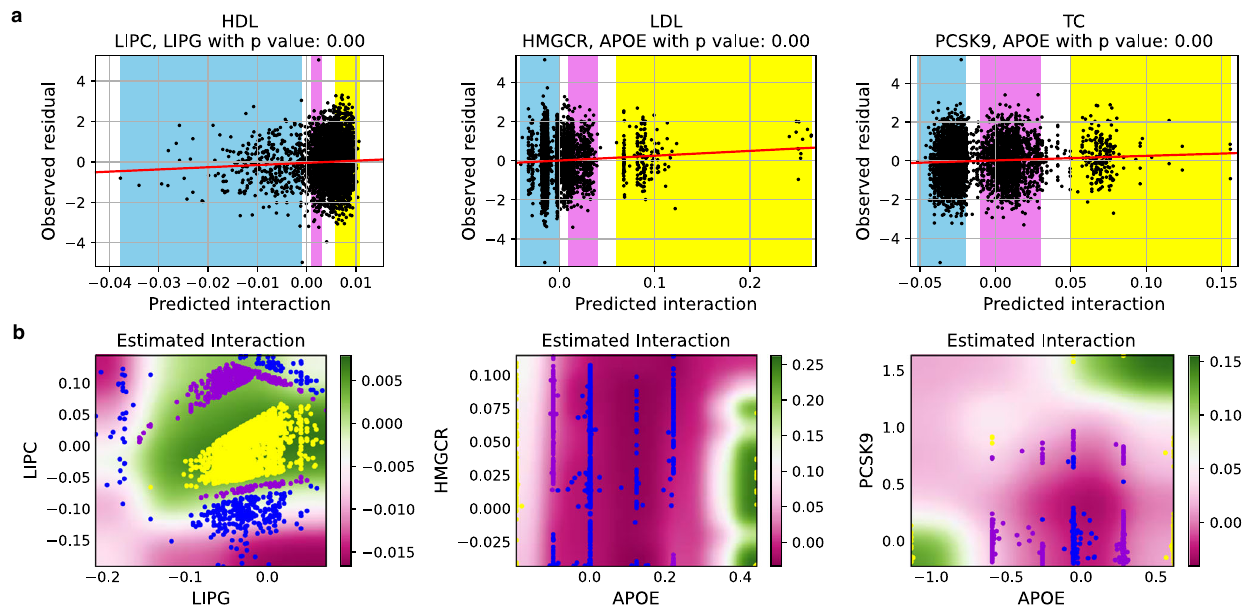
Fig. 7 Visualization of one interaction replicated in the FINRISK dataset of each phenotype. a X axis represents the interaction predicted in FINRISK using the model trained on the UK Biobank. Y-axis shows the residual after removing the main effects in the FINRISK dataset; see Eq. (5). The interactions learned from the UK Biobank (x-axis) signi fi cantly explain the variation in the phenotype of FINRISK that remains after excluding the main effects ( y axis). b Heatmaps representing the estimated interaction (background color) between two gene representations (x-axis and y-axis) learned from the UK Biobank. Blue, purple, and yellow backgrounds in the panel ( a ) represent individuals with low, medium, and high predicted interaction values, and they are shown with dots in the panel ( b ). It is clear that the replicable interactions have complex shapes which can not be approximated well by multiplicative